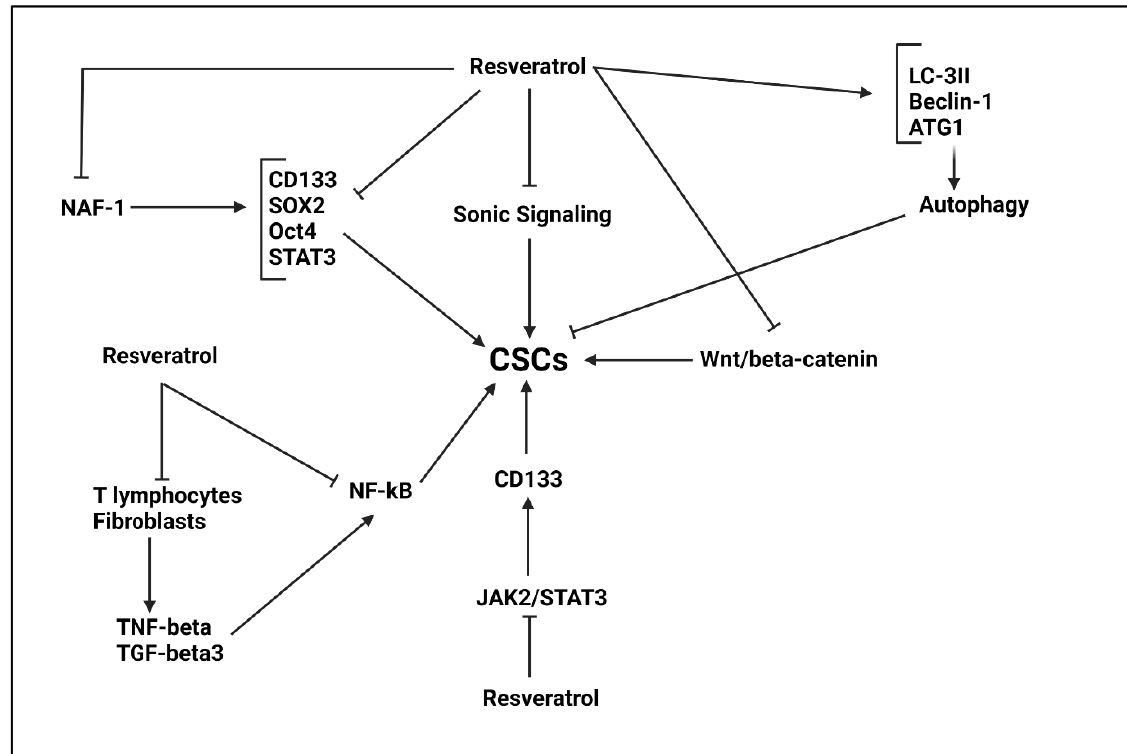
Figure 6. Res in suppressing CSCs in tumor therapy.